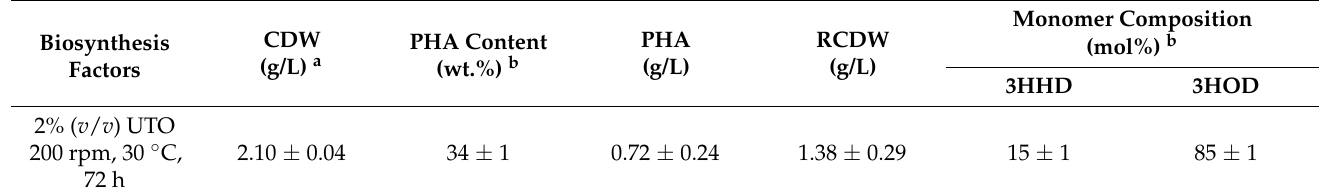
Table 1. PHA biosynthesis by Acinetobacter sp. strain AAAID-1.5 using used transformer oil as the sole carbon source.